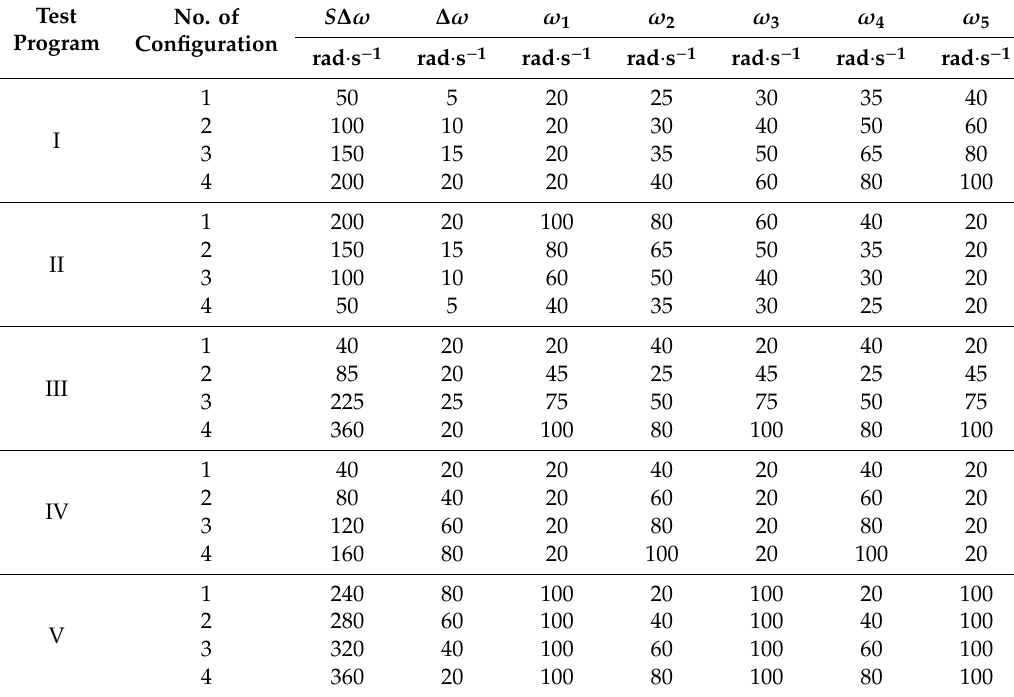
Table 3. Settings of the five-disc mill control parameters